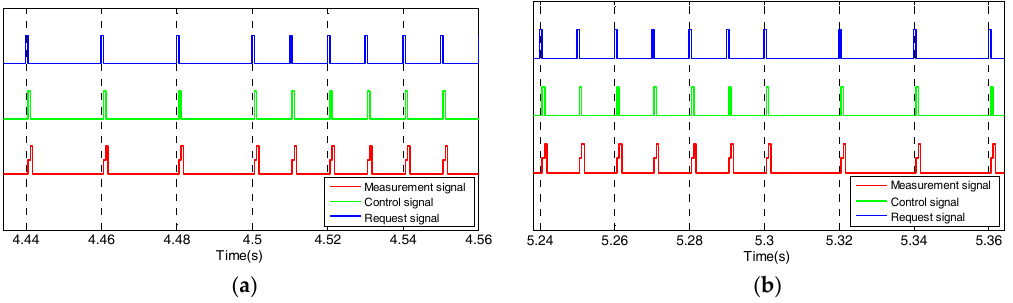
Figure 9. Sampling period and network utilization rate results in simulations. ( a ) Sampling periods in the upshift process; and ( b ) CAN utilization rates of the loop in the upshift process.